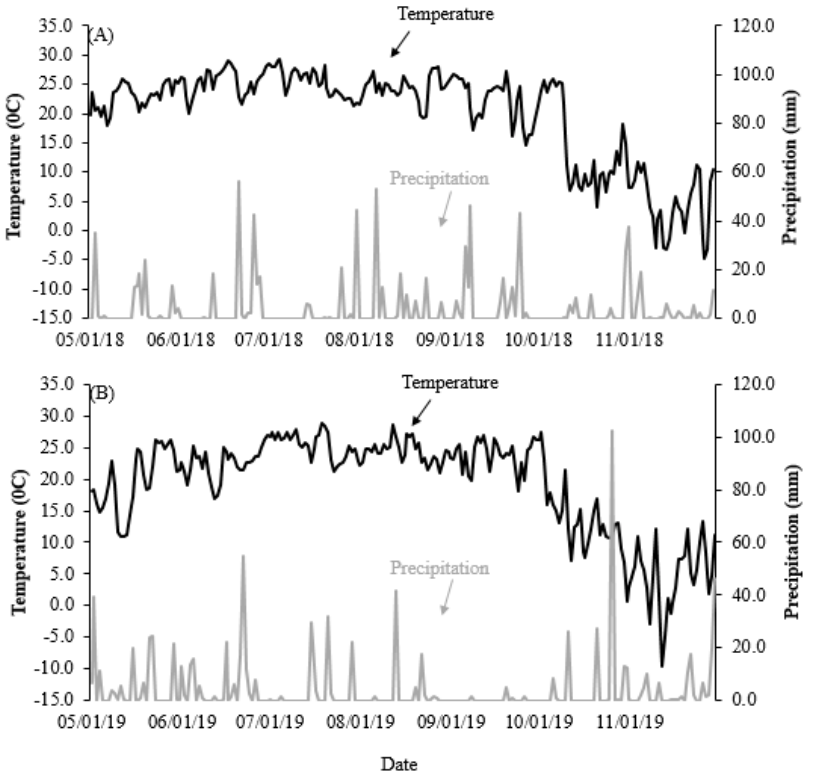
Figure 1. Average air temperature and cumulative monthly precipitation during corn growing season in 2018 ( A ) and 2019 ( B ) in Carbondale, Illinois.